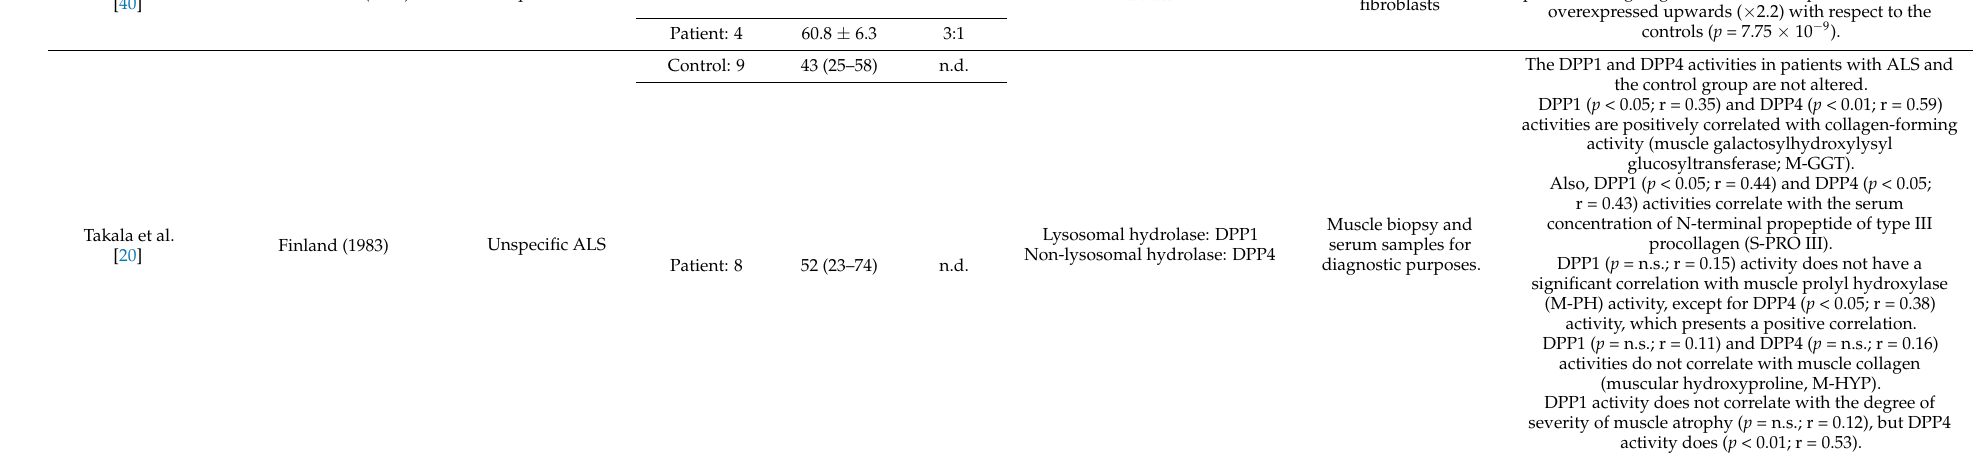
Cultures of human fibroblasts